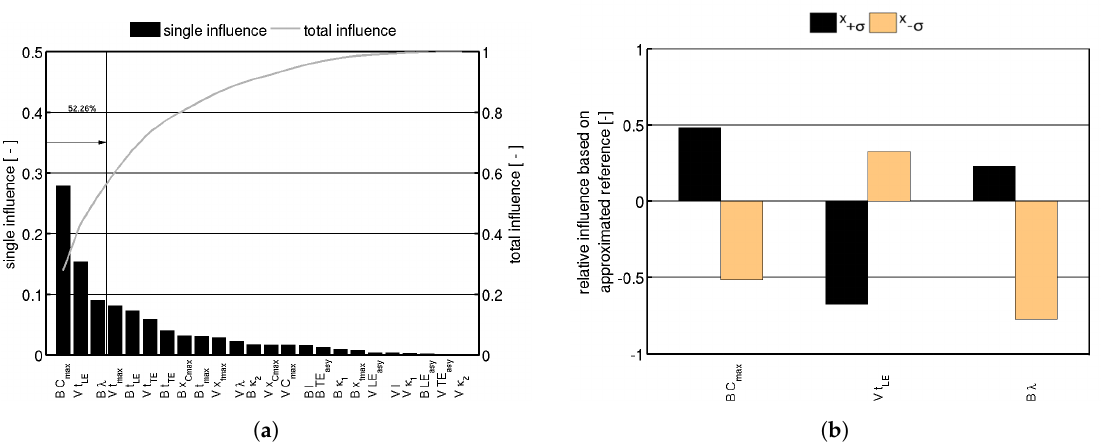
Figure 2. Rear-stage sensitivities of isentropic efficiency η is . ( a ) Pareto chart of isentropic efficiency η is at the rear stage. ( b ) Sensitivies of η is to geometric changes at the rear